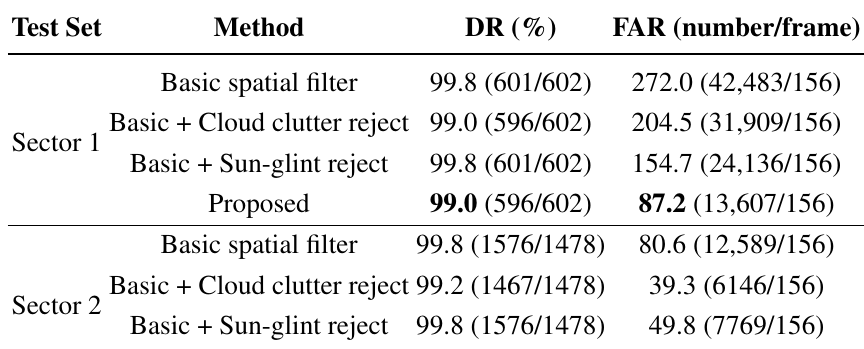
Table 6. Comparison of clutter rejection